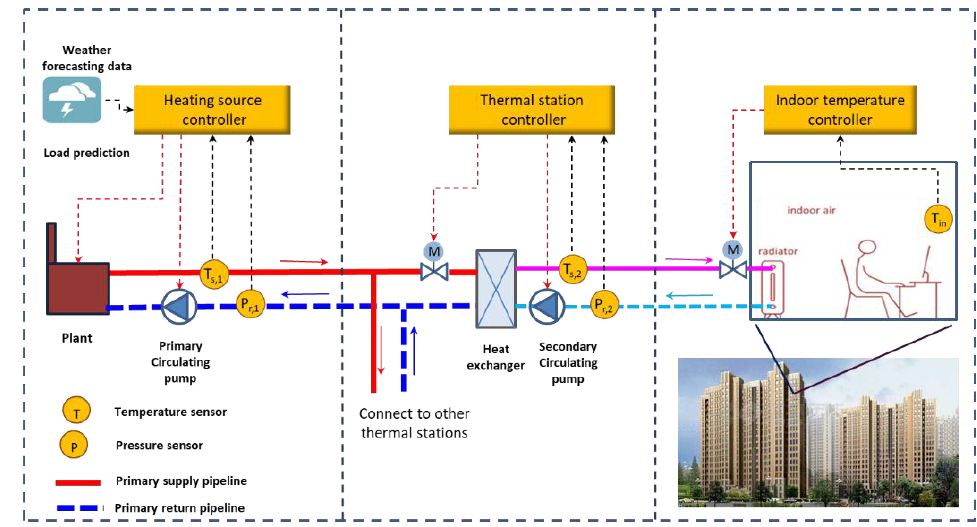
Figure 1. Schematic of a heating system.